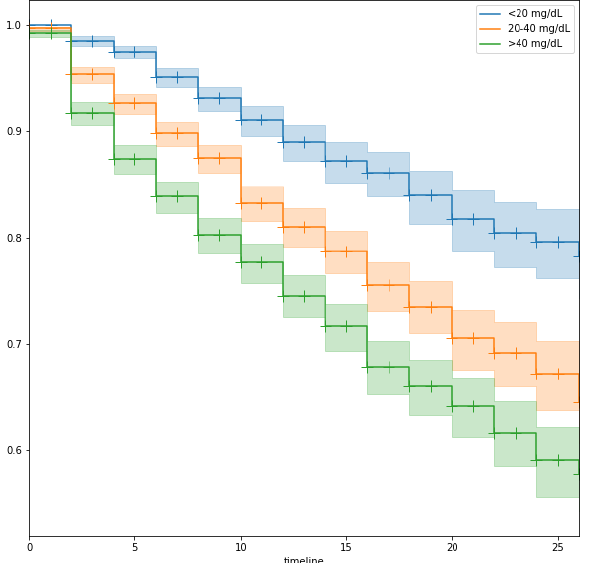
Fig. 2. Kaplan-Meier curves for 28 days all cause mortality of eICU patients according admission estimated GFR (MDRD). group comparison by log-rank test , P <0.001